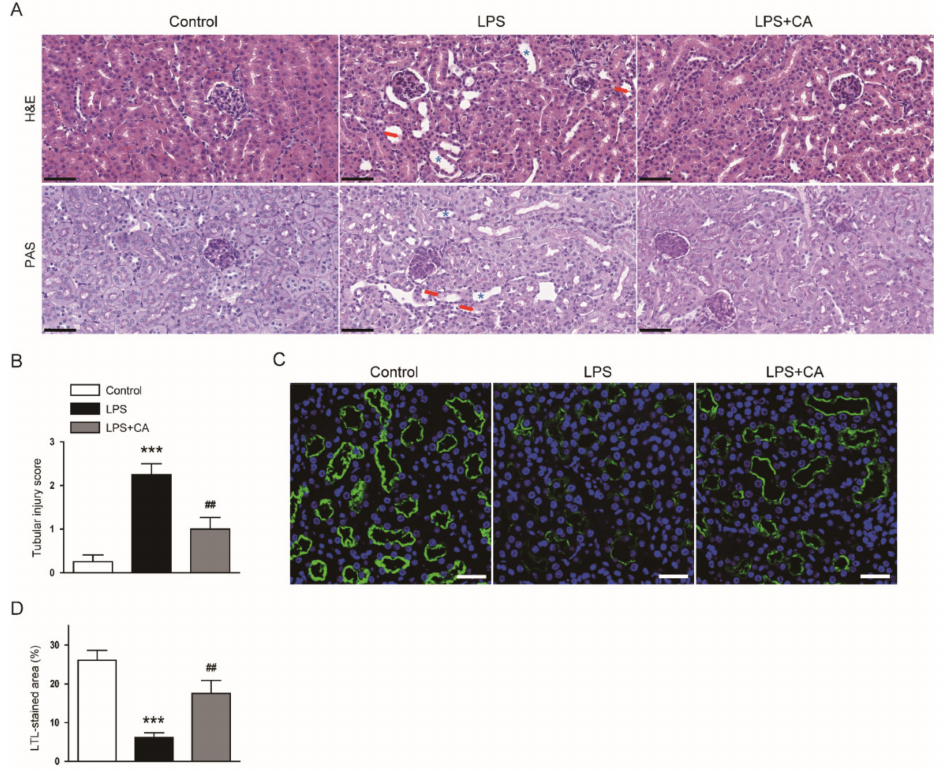
Figure 1. Effect of carnosic acid on histopathological features. ( A ) H&E and PAS staining. Scale bar: 50 µ m. Red arrows indicate tubular cell detachment. Blue asterisks indicate dilated tubules. ( B ) Tubular injury score. ( C ) IF staining for LTL (green) on kidney sections. To stain nuclei, DAPI (blue) was used. Scale bar: 40 µ m. ( D ) Percentage of LTL-stained cells. n = 8 per group of mice. *** p < 0.001 versus control. ## p < 0.01 versus